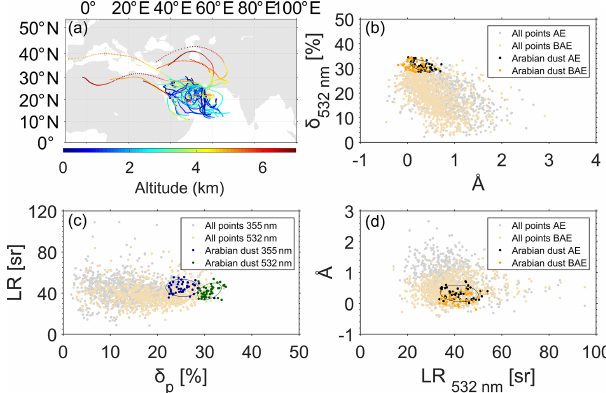
Figure 7. Height-dependent aerosol properties for 0–1, 1–2, 2– 3, 3–4, and > 5km altitude. (a) Backscatter coefficient at 355nm (blue), 532nm (green), and 1064nm (red). (b) Extinction co- efficient at 355nm and 532nm. (c) Lidar ratio at 355nm and 532nm. (d) Linear particle depolarization ratio at 355nm and 532nm. (e) Extinction-related Ångström exponent (AE) at 355/532, backscatter-related Ångström exponent (BAE1) at 355/532, and backscatter-related Ångström exponent (BAE2) at 532/1064.